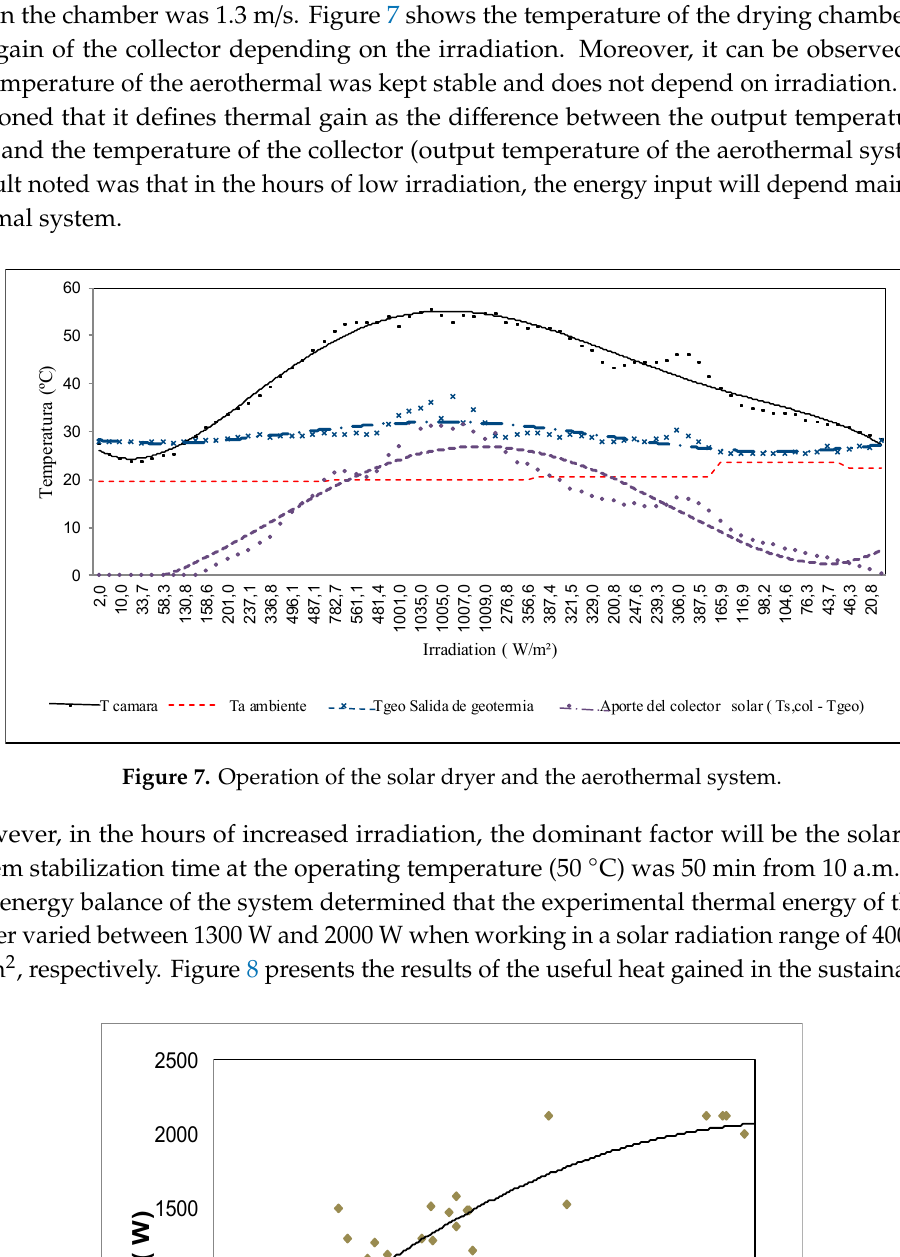
Figure 6. Soil surface temperature profile.